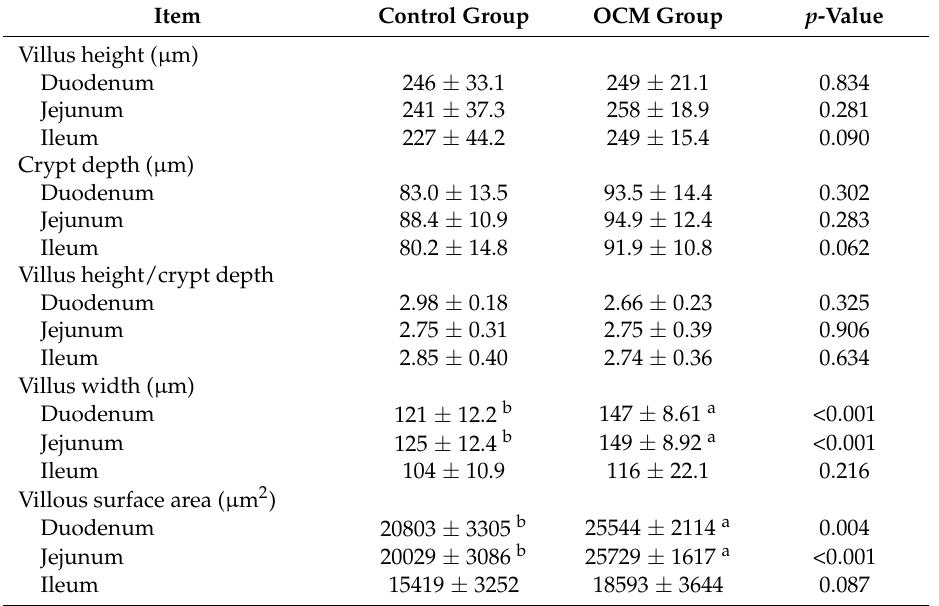
Table 3. Effects of dietary supplementation with OCM (50 mg/kg diet) on the intestinal histology of piglets.